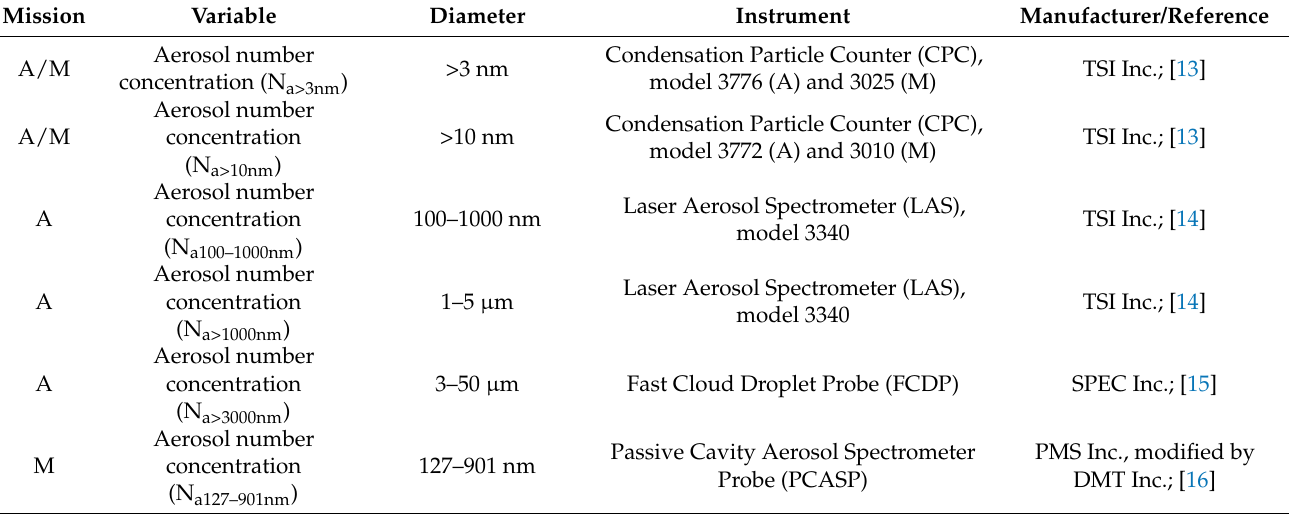
Table 1. List of relevant variables for this study as measured by the Twin Otter in 2019 MONARC (M) flights and from the Falcon in 2020 ACTIVATE (A) flights, including instrument